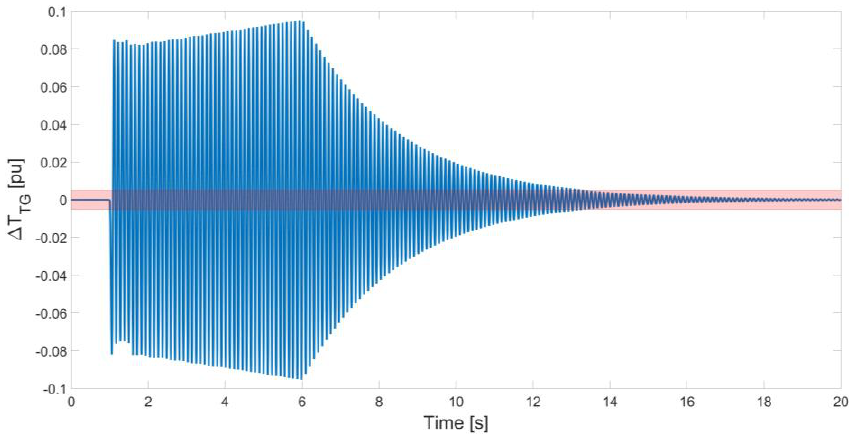
Figure 6. Torque oscillation ∆ T TG mitigation at the first TNF obtained applying the method [14].